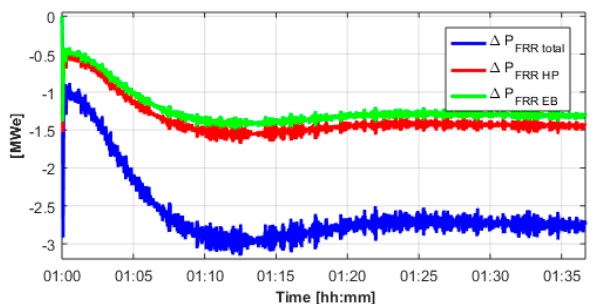
Figure 16. Setpoints for frequency regulation reserve (FRR) actions at the Balance Responsible Party (BRP) level.